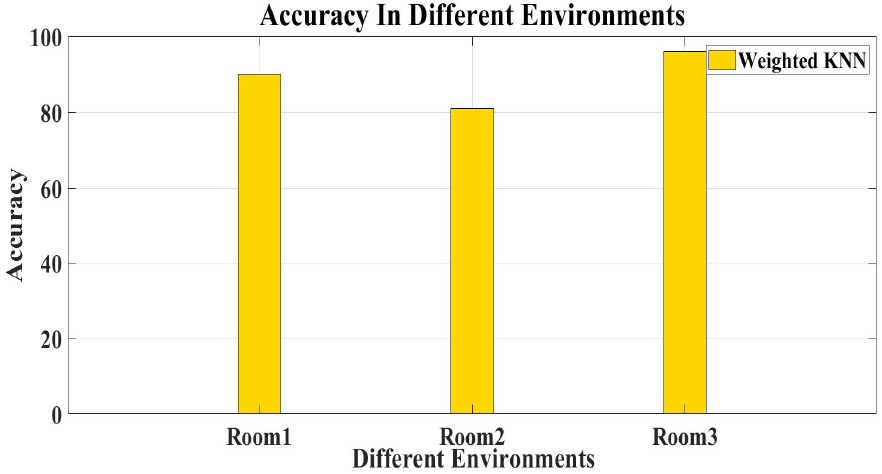
Figure 12. Recognition accuracy in different environments.